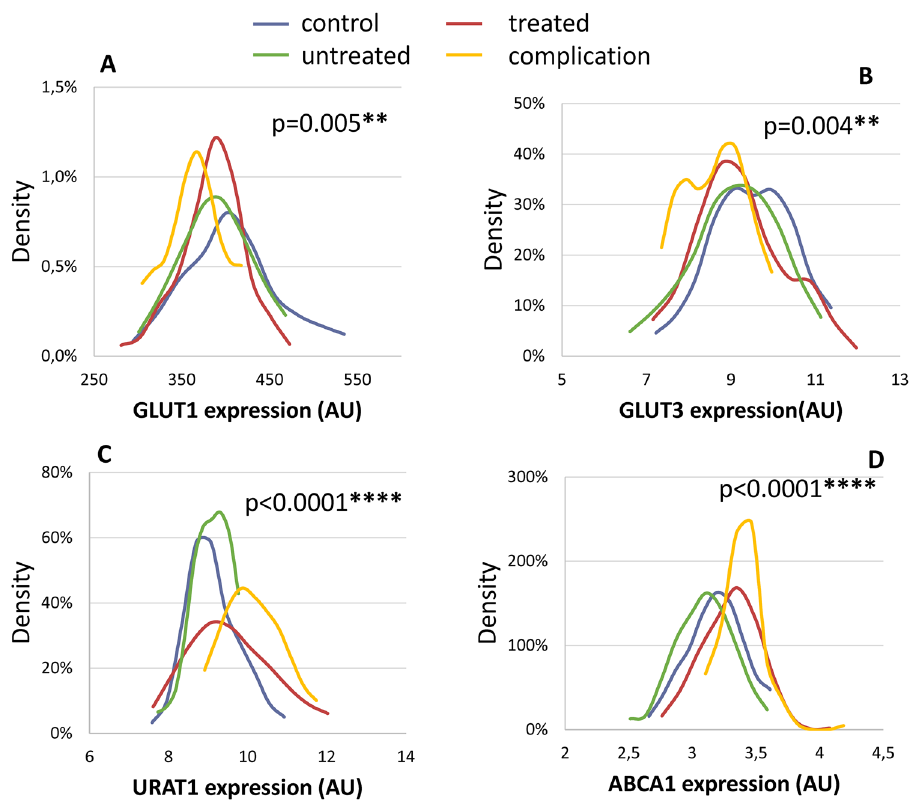
Figure 3. Kernel density diagrams and the p values obtained for the statistical differences between the protein expression values within the groups. The p values were analyzed by the Kruskal–Wallis test. ( A ) GLUT1; ( B ) GLUT3; ( C ) URAT1; ( D ) ABCA1. Blue: control individuals (n = 59, except in MCT1, n = 54) grey: recently diagnosed, untreated T2DM patients (n = 36, except for MCT1, n = 31), red: successfully managed patients (n = 61, except for MCT1, n = 55), and orange: patients showing treatment resistance or disease-related complications (n =